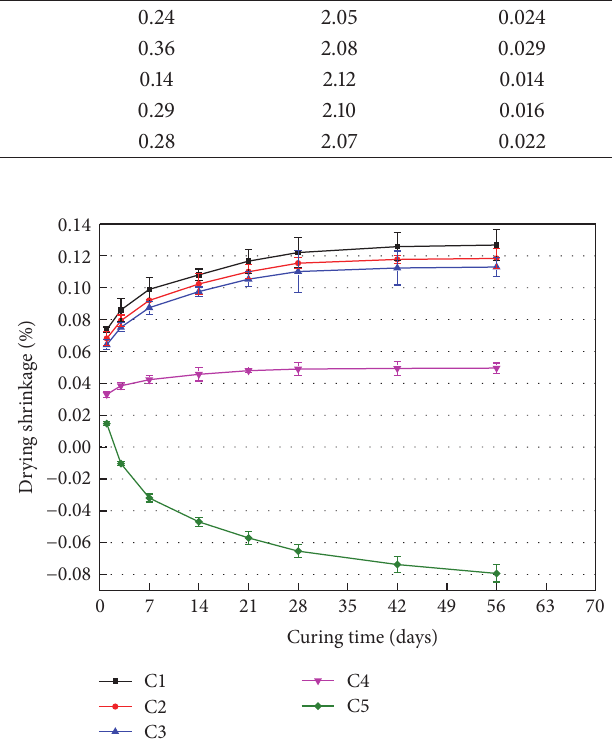
Figure 5: Development of dry shrinkage of designed